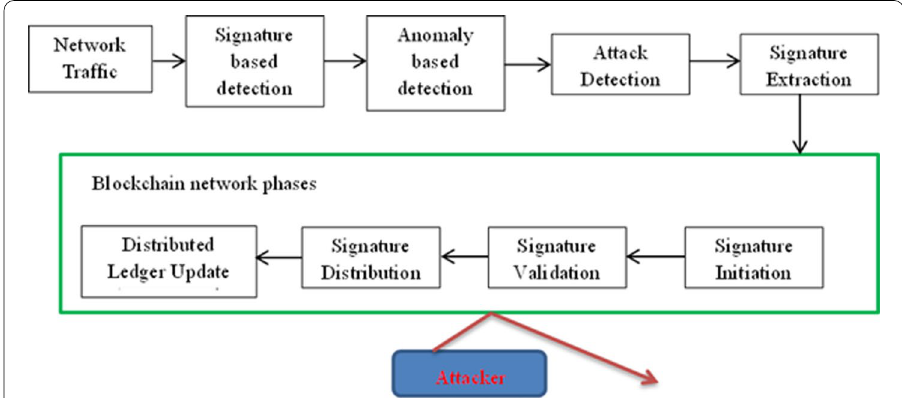
Fig. 1 System architecture of proposed system BC-HyIDS using blockchain. The top view of the architecture which elaborates all the phases of prototype. Each step of the architecture is explained including blockchain framework. All the steps included in blockchain framework are explained in block. This framework will provide security to the system such that attackers will not able to penetrate attacks in network. This framework provides immutable data